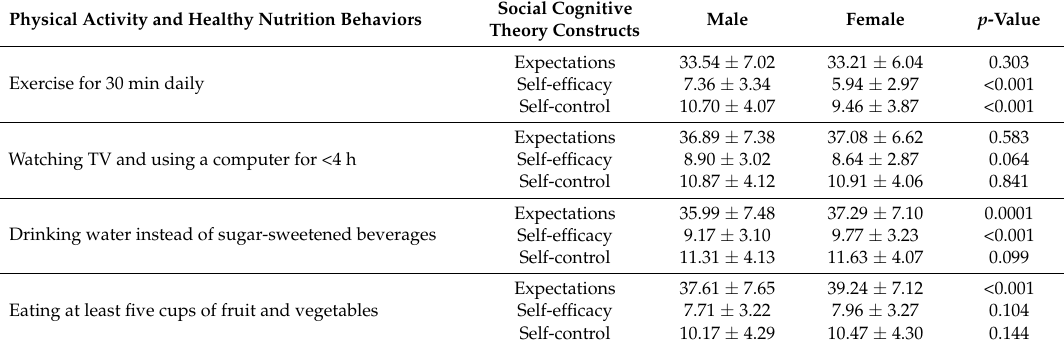
Table 3. Constructs of social cognitive theory in undergraduate students by gender in Chongqing, China,